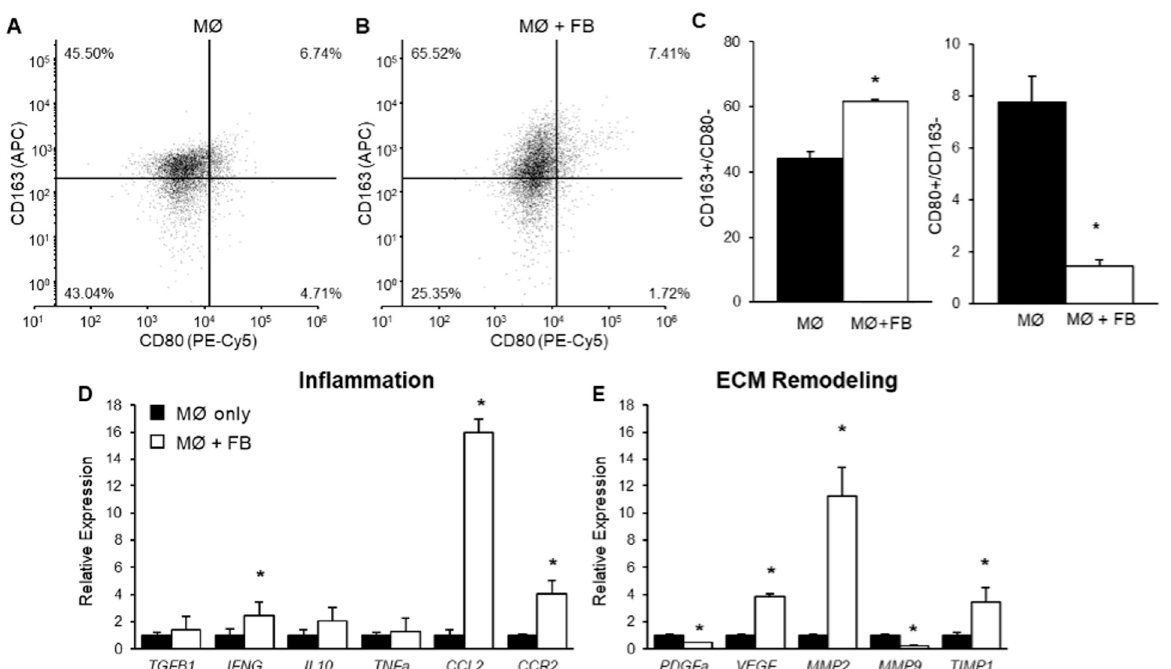
Figure 1. THP-1-derived macrophage phenotype following indirect co-culture with mammary fibroblasts. PMA-treated THP-1 derived macrophages (0.5 × 10 6 cells/mL) were cultured alone (MØ only), or indirectly with primary mammary fibroblasts (FB + MØ) for 72 h. Cell surface marker expression of CD163 and CD80 on THP-1 derived macrophages were detected using flow cytometry in ( A ) macrophage only cultures ( n = 6) and ( B ) macrophages in indirect co-culture with primary mammary fibroblasts ( n = 6). ( C ) The percentage of viable cells, which are CD163+/CD80 − or CD80+/CD163 − in each culture condition. Expression of genes associated with ( D ) inflammatory and ( E ) extracellular matrix (ECM) remodelling were assessed through RT-PCR. Gene expression was normalised to the housekeeping gene HPRT1. Results are presented relative to macrophage-only cultures. Data presented as mean + SEM. Statistical analysis was performed using a linear mixed effects model with Tukey’s post hoc comparison. Statistical significance is indicated by * when p <